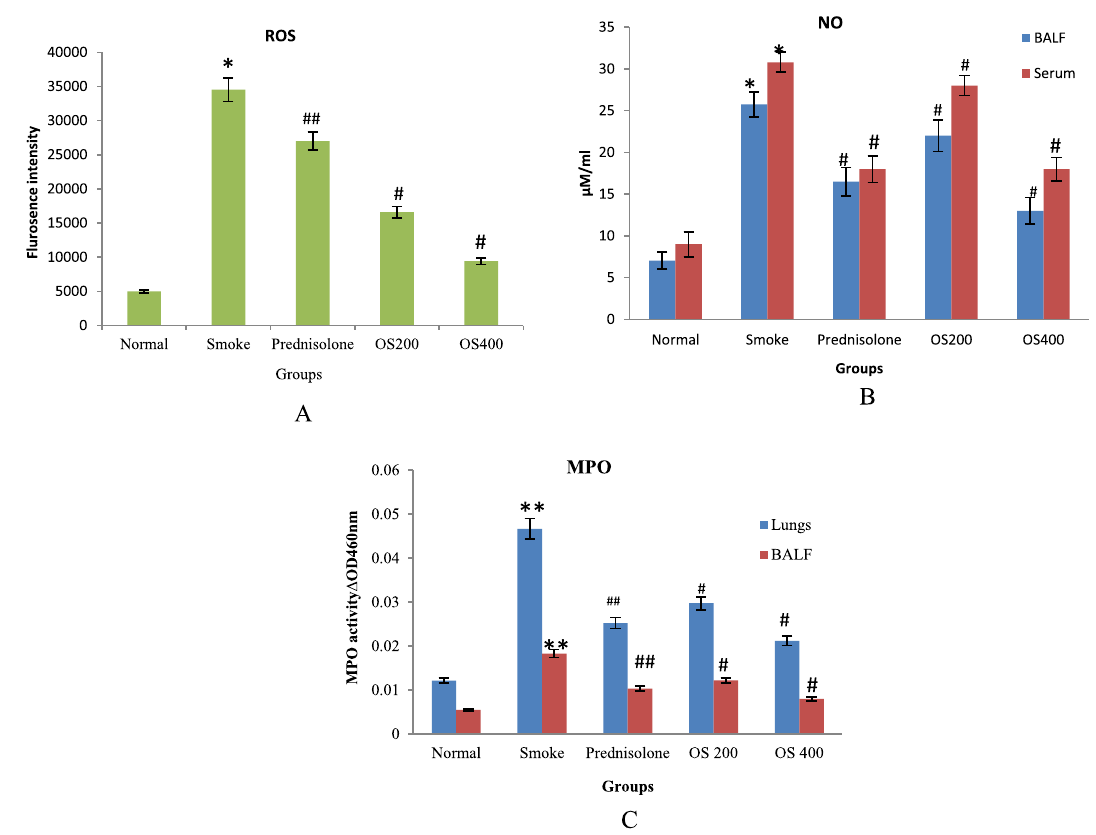
Figure 4. Effect of OLE on ROS ( A ), Nitrate ( B ) production and MPO level ( C ) in CS exposed mice: The increased level of ROS, nitrate and MPO in CS − induced mice was decreased with the pre − administration of 200 mg/kg and 400 mg/kg OLE. Values are expressed as mean ± SEM. Results were analysed statistically by one way ANNOVA followed by Turkey’s test. *p < 0.01 and **p < 0.05 versus the normal group; # p < 0.01 and ## p < 0.05 versus the COPD